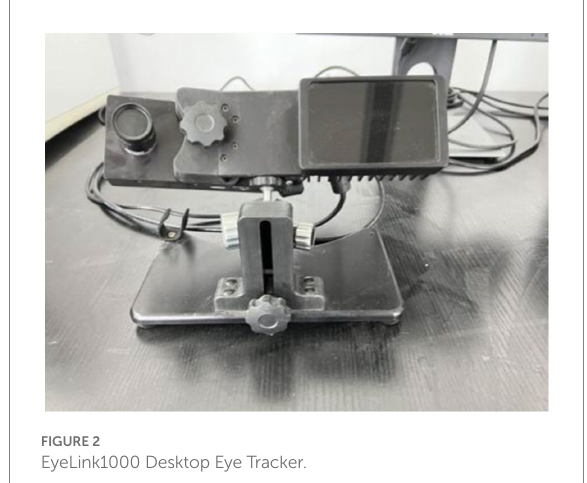
FIGURE 2 EyeLink1000 Desktop Eye Tracker.